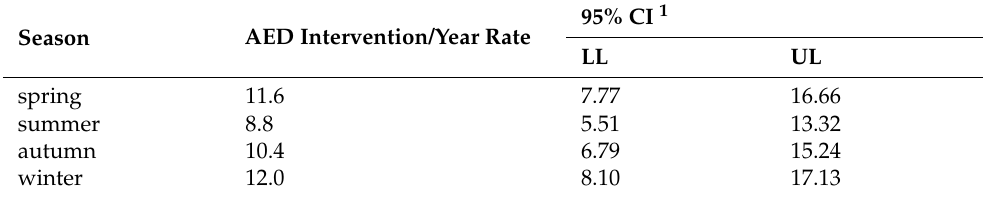
Table 4. Frequency of AED interventions by season.